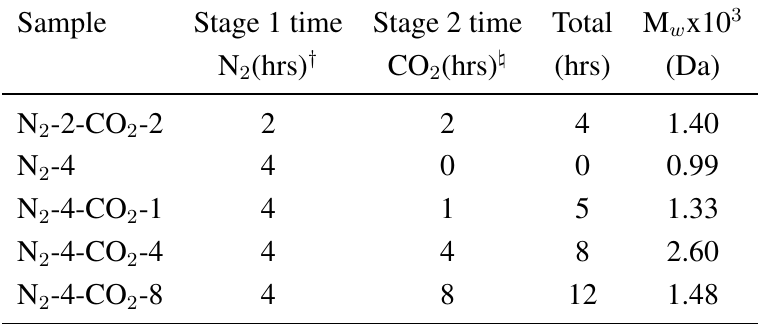
and CO at 150 ◦ C . Two-stage process. 2 2